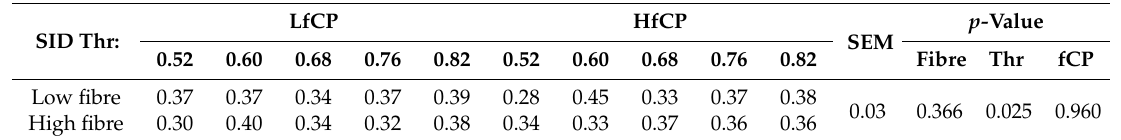
Table 5. Serum antioxidant concentration (Mm) 1,2